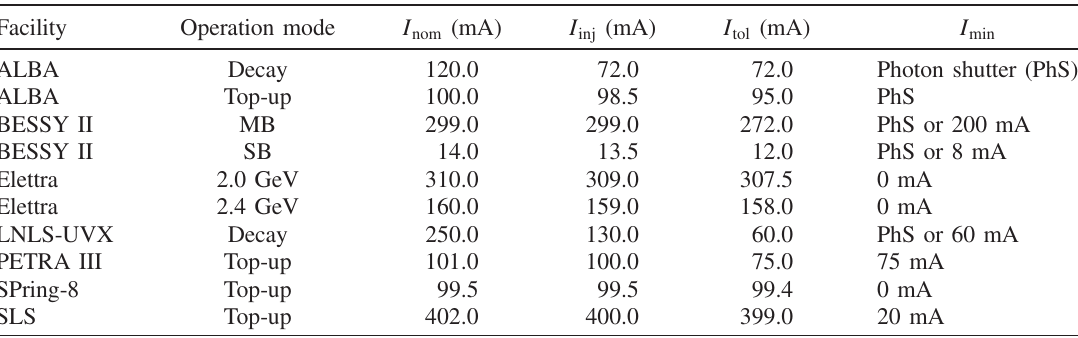
TABLE II. Primary failure mode